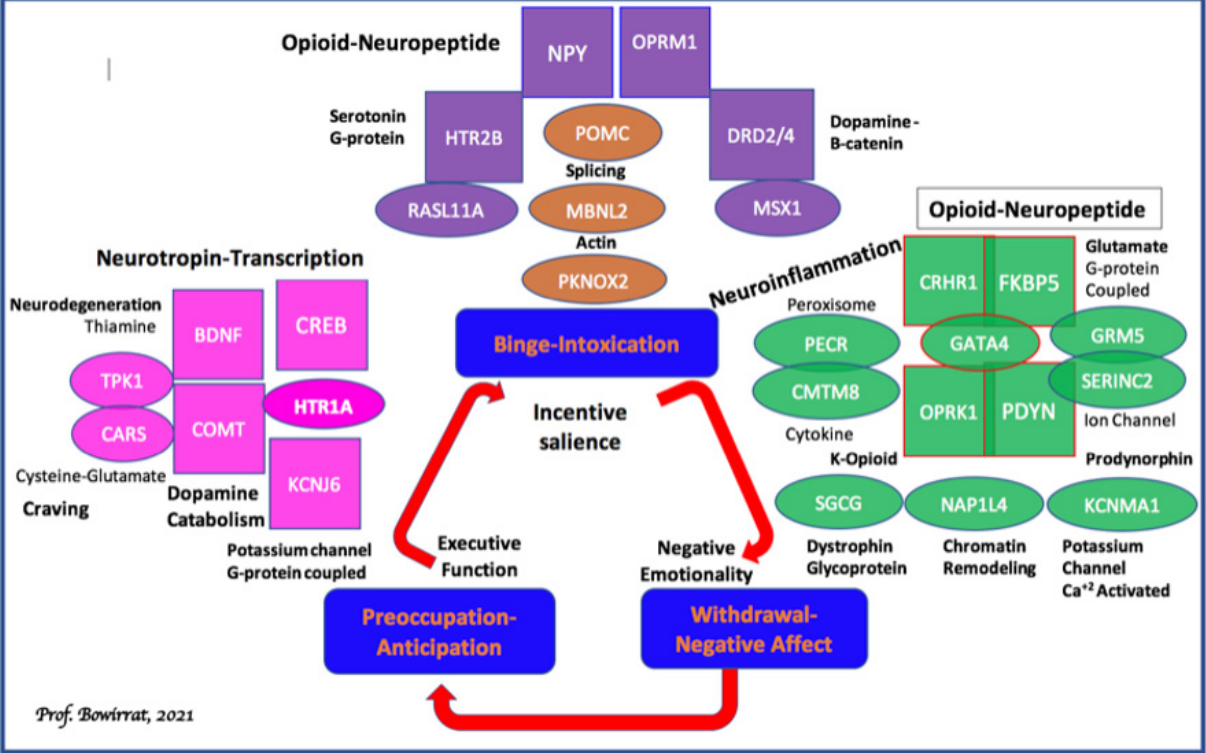
Figure 4. Candidate genes for alcohol dependence characterized into stages of the addiction cycle : This schematic shows the three stages of the addiction cycle: (1): binge-intoxication (blue), (2): withdrawal-negative affect (red), and (3): preoccupation-anticipation (green); also shown are behavioral domains linked to each stage of the cycle: incentive salience, negative emotionality, and executive function, respectively. Candidate functional genes identified by non-GWAS approaches are shown in ovals and colored coded according to the relevant addiction stage the gene is hypothesized to function. GWAS candidates are shown in rectangles color-coded according to the relevant addiction stage the gene is hypothesized to function. The general biological function of each gene in the figure is highlighted in black. Non-GWAS functional gene relationships are indicated by overlapping ovals. Hypothesized functional relationships between non-GWAS genes and GWAS candidates are indicated by overlapping ovals and rectangles. GWAS candidates in each stage are grouped according to potential biological functional similarities where possible. Finally, one example of pleiotropy is shown in the preoccupation-anticipation stage. BDNF-COMT functional variants have pleiotropic effects in both the preoccupation-anticipation stage and the withdrawal-negative affect stage [112].